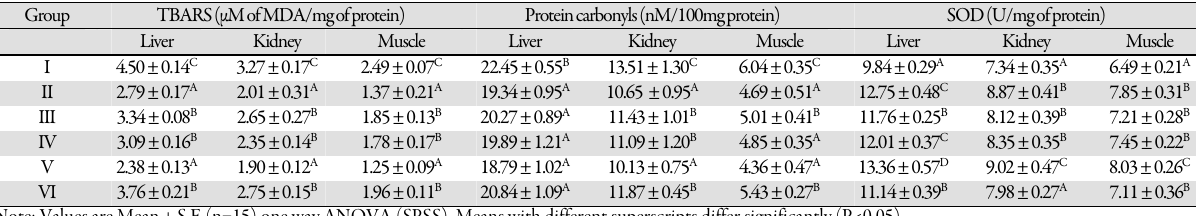
Table 1. Antioxidant profile of different tissues from birds fed with neem leaf and/or spirulina substituted diet Group TBARS (µM of MDA/mg of protein) Protein carbonyls (nM/100mg protein)